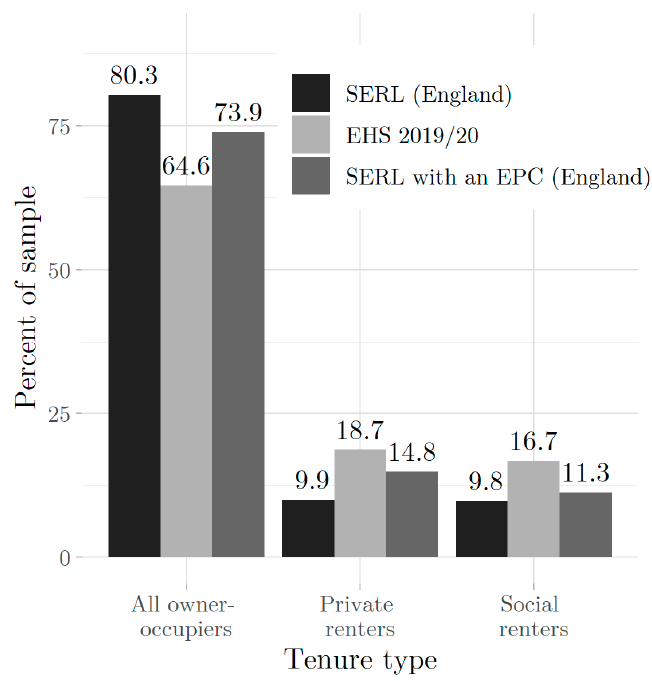
Figure 23. Tenure types among SERL survey respondents in England (counts rounded down to the nearest 20 for statistical disclosure control), EHS respondents and SERL survey respondents in England with an EPC.